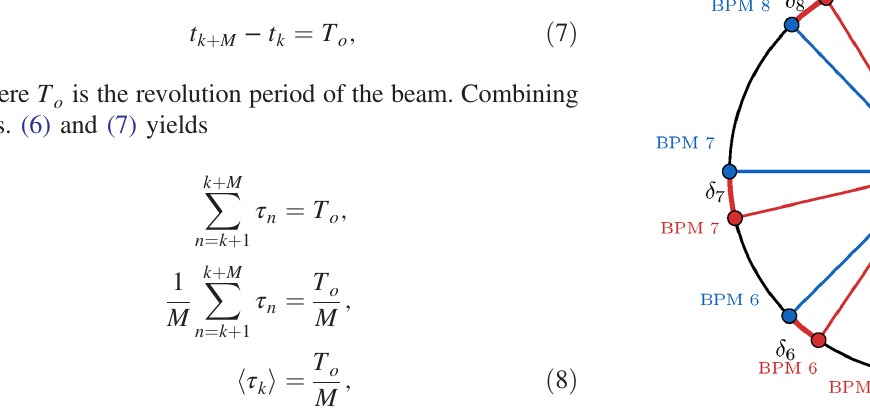
is introduced, due k